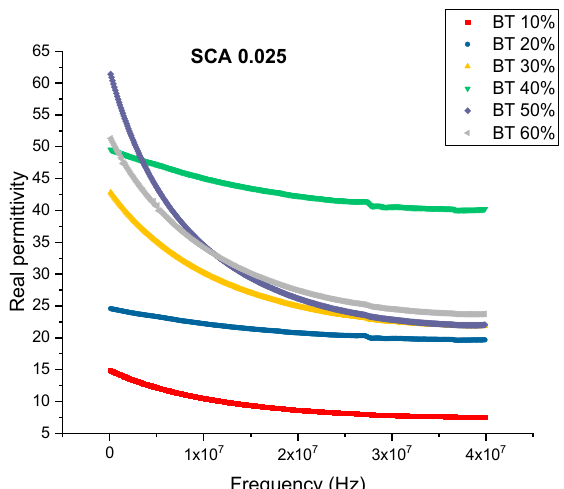
Figure 17. The real permittivity of the BaTiO 3 -epoxy composite that were fabricated using BaTiO 3 nanoparticles which were surface modified using 0.025 SCA is plotted as a function of frequency where the volume fraction of BaTiO 3 is varied from 0.1 to 0.6. A comparison of the experimental relative permittivity values and theoretical models is plotted in Figure 18. The mathematical models used were the Maxwell-Garnett equation, Bruggeman self- consistent effective medium approximation, the Jaysundere-Smith equation and Lichtenker rule. Table 3 lists the values of the values obtained from the mathematical models and the experimental values obtained at 20MHz.